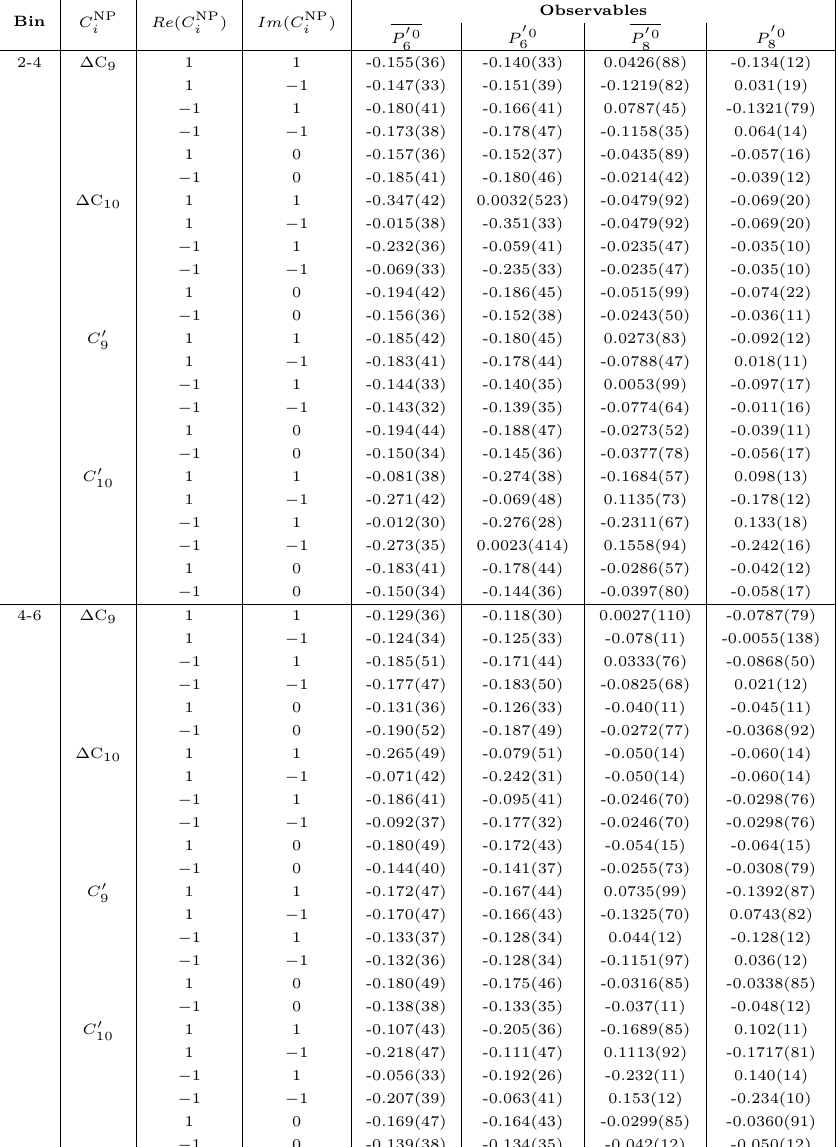
¯ B 0 → ρ 0 ll and C 0 for the q 2 bins 9 , 10 9 , 10